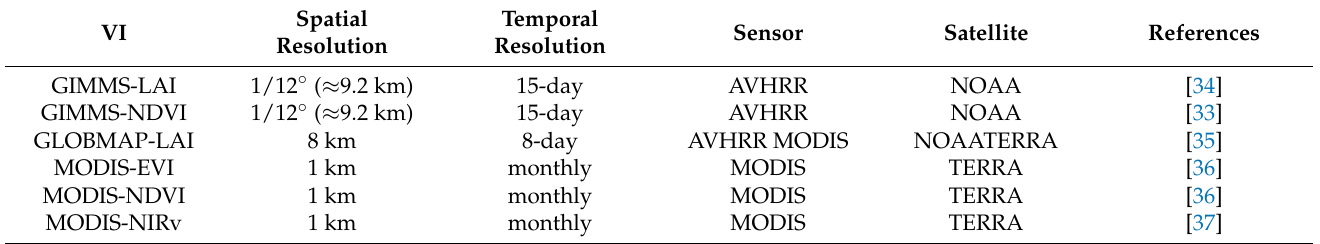
Table 1. Remote-sensing-derived VI datasets used in this